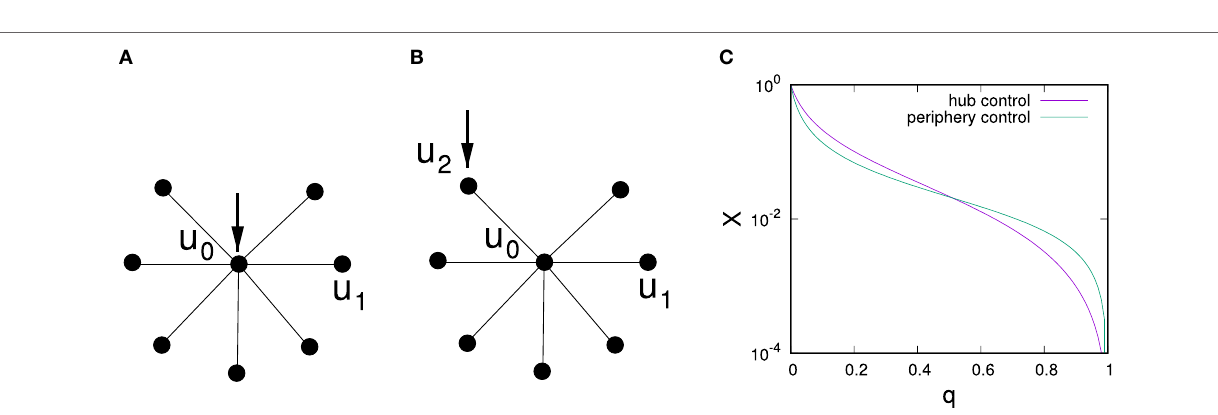
Frontiers in Robotics and AI |